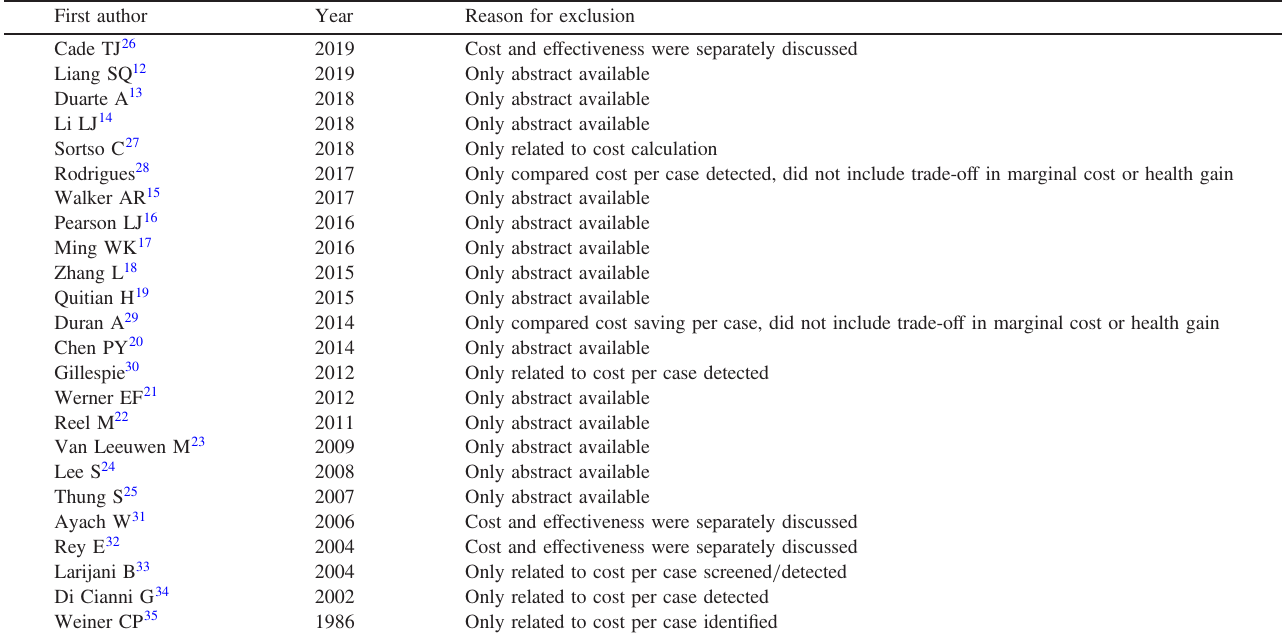
Table 1. Characteristics of excluded studies at second-level screening